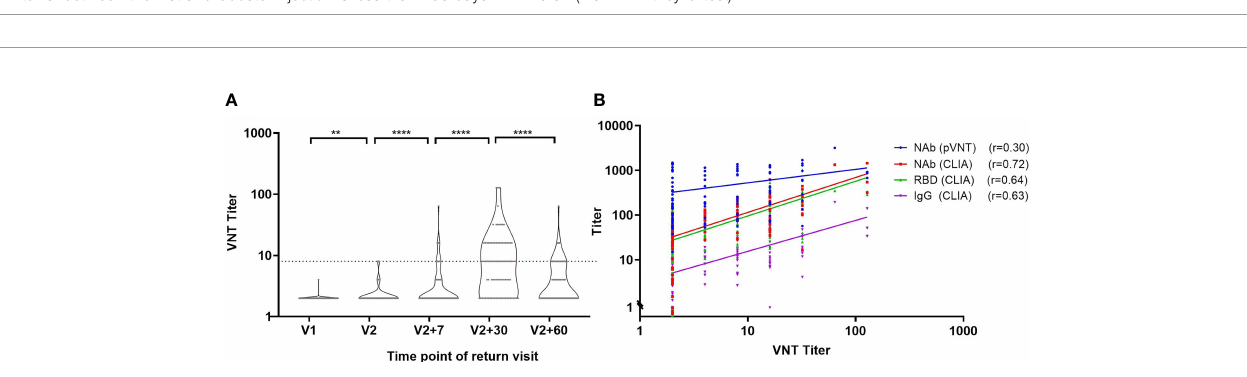
FIGURE 4 | Effects of different inoculation intervals on antibody levels. (A) The relationship between NAb titer level and the time interval for the fi rst two injections. (B) The relationship between NAb titer level and the time interval for the fi rst and booster injection. >30: the interval between the fi rst two injections is longer than or equal to 30 days. <30: the interval between the fi rst two injections is less than 30 days. >230: the interval between the fi rst and booster injection is longer than or equal to 230 days. <230: the interval between the fi rst and booster injection is less than 230 days. **P ≤ 0.01 (Mann-Whitney U test).